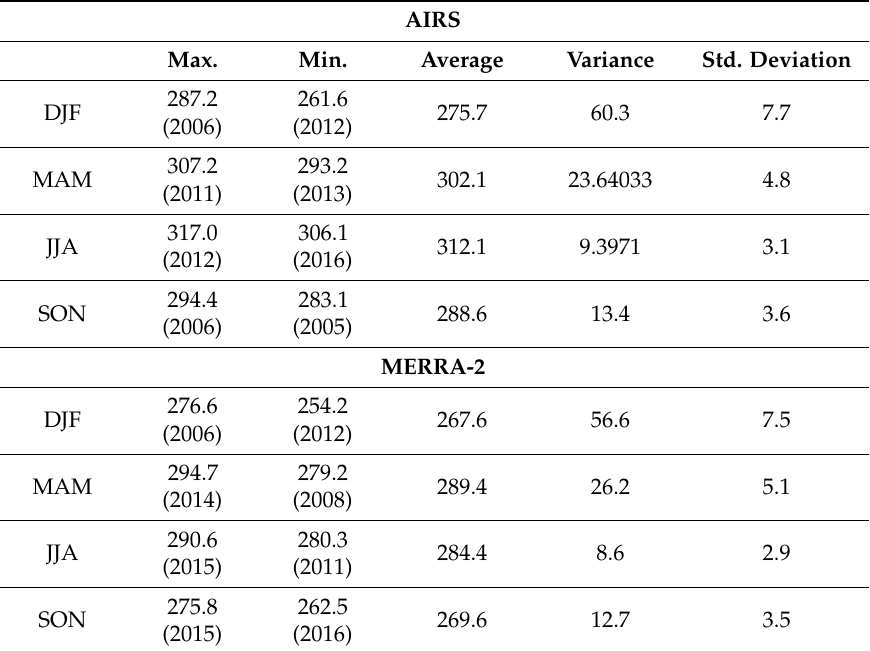
Table 5. Seasonal average time series statistics of TOC for 12 years from both AIRS and MERRA-2. The numbers in the parentheses represent the corresponding year.